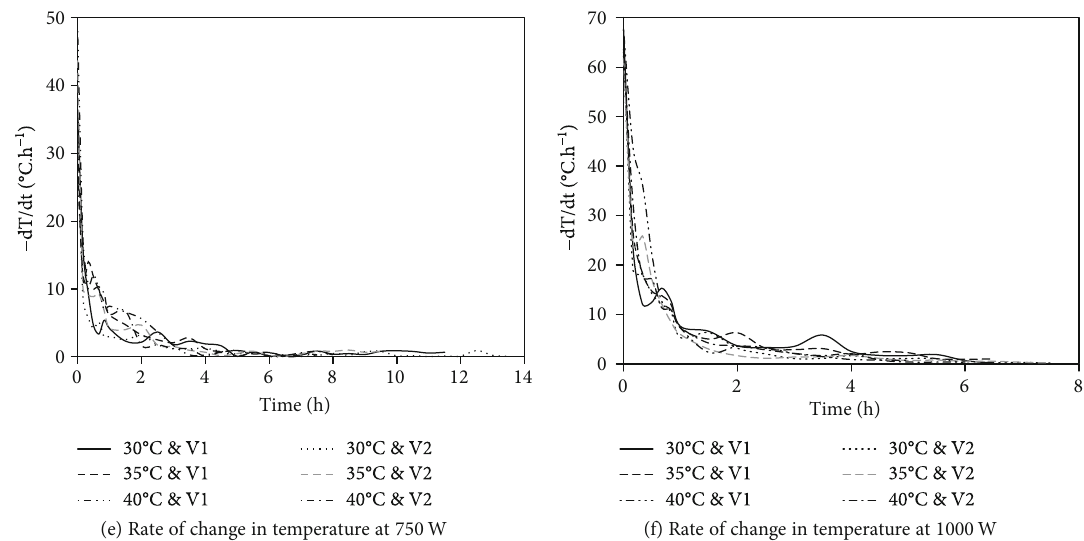
Figure 4: Variation in the drying rate and the rate of change in the core temperature of the beef sample during drying. Table 5: E ff ective moisture di ff usivity of marinated beef during IRHAD. Drying air temperature ( °